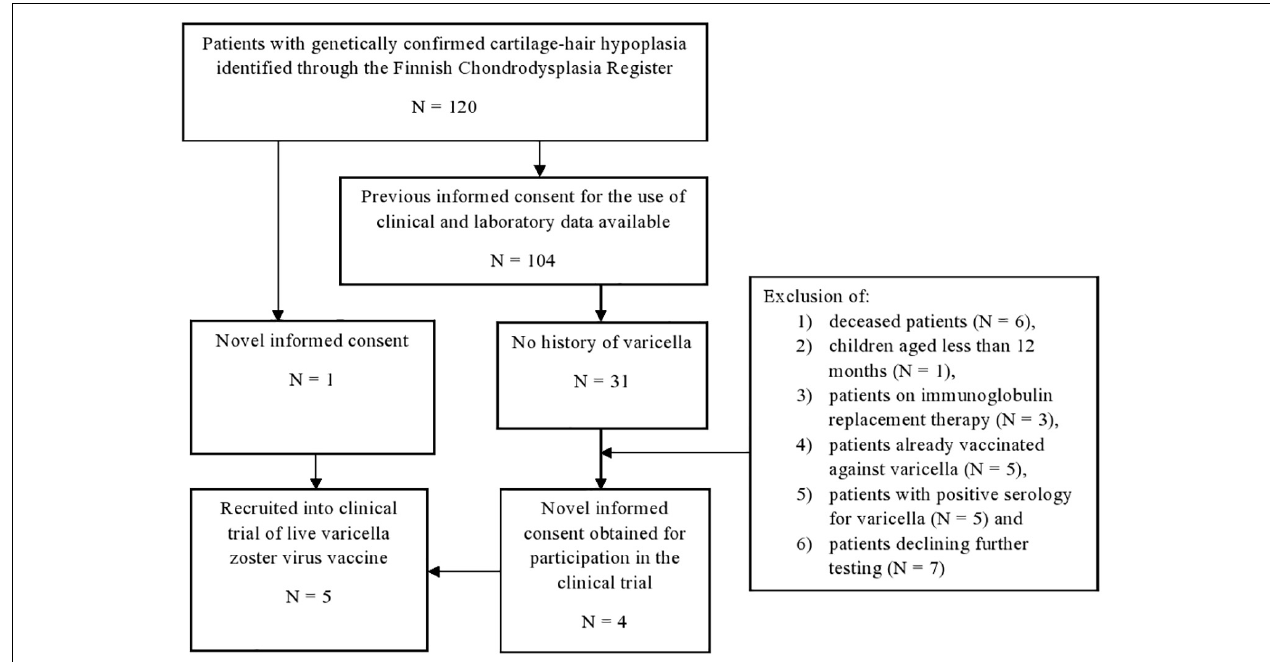
FIGURE 1 | Recruitment to the clinical trial of safety and efficacy of live varicella zoster virus vaccine in patients with cartilage-hair hypoplasia.